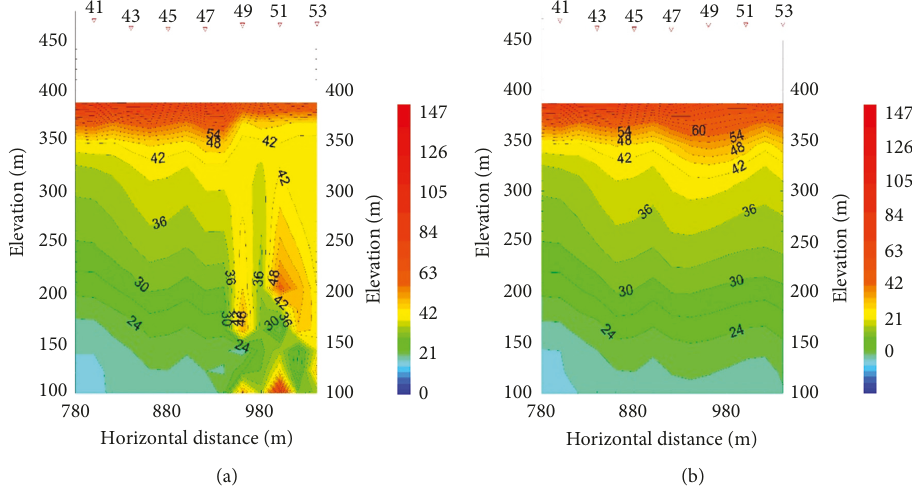
Figure 8: Comparison of pseudosection of resistivity (a) before and (b) after interference correction.